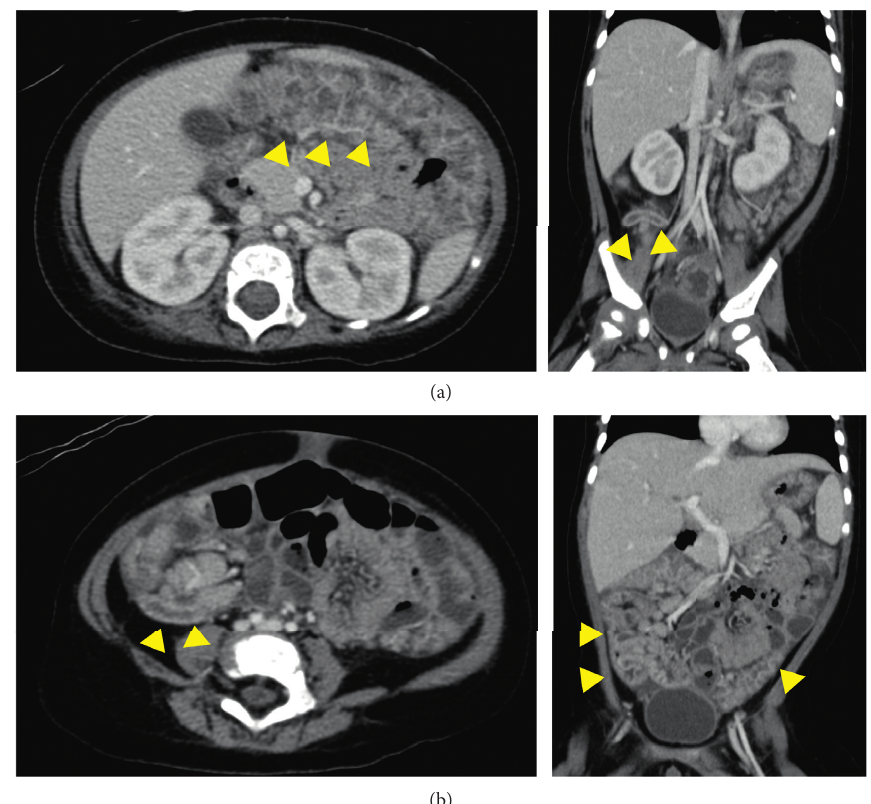
Figure 4: Abdominal computed tomography revealing pitting-like wall thickness of the entire colon, mesenteric lymphadenopathy of the right lower abdomen, and enlarged